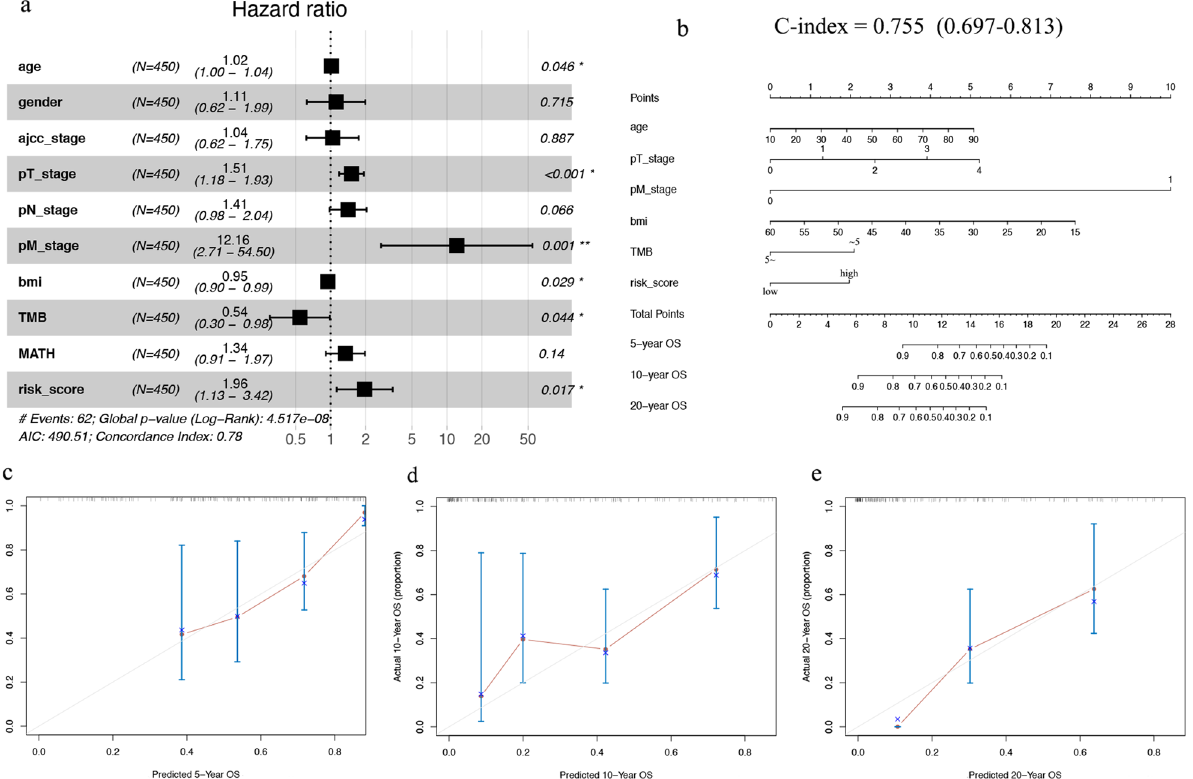
Figure 4. Predictive nomogram construction. ( a ) Hazard ratio and p ‐ value of the clinicopathological factors and risk scores involved in multivariate Cox regression in the overall cohort. ( b ) Nomogram to predict the overall survival rate of 5 years, 10 years and 20 years of patients with SKCM. ( c–e ) Calibration curve for the nomogram. SKCM skin cutaneous melanoma.